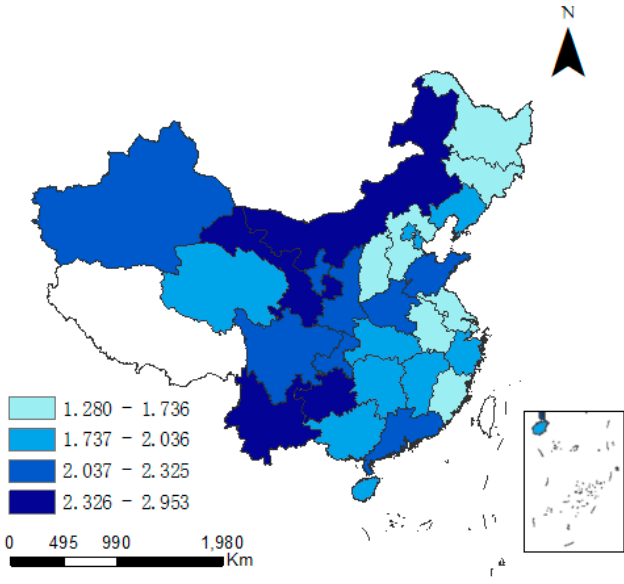
Figure 5. Industrial pollution emissions in 2015.